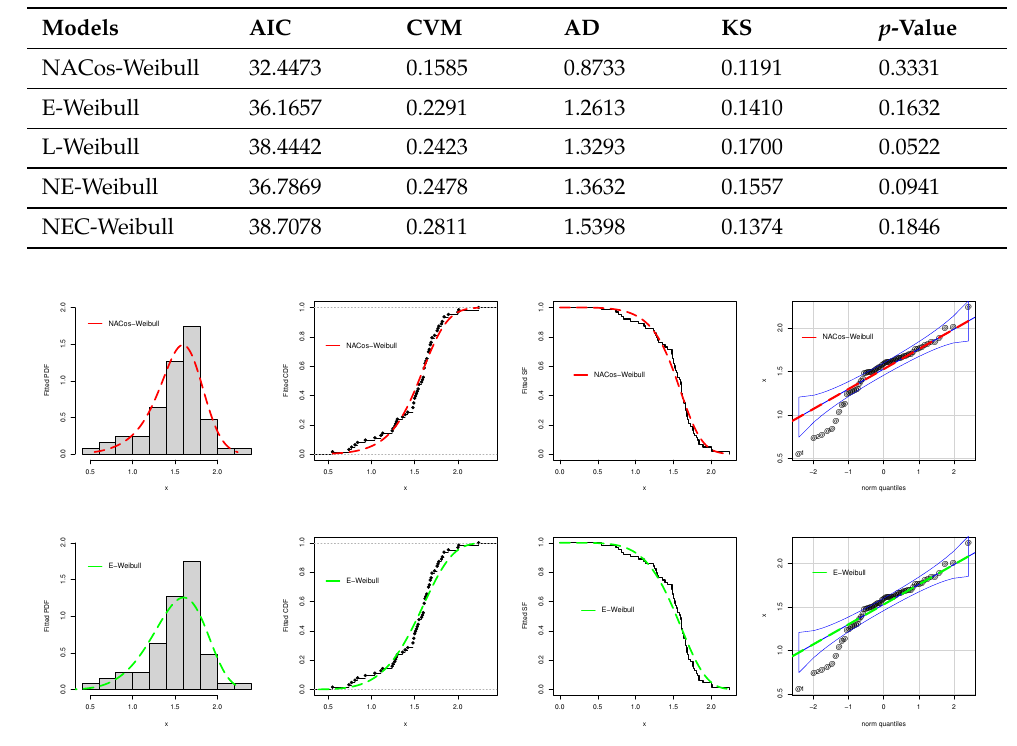
Table 12. For the glass fibers data set, the values of the selection criteria of the fitted distributions.